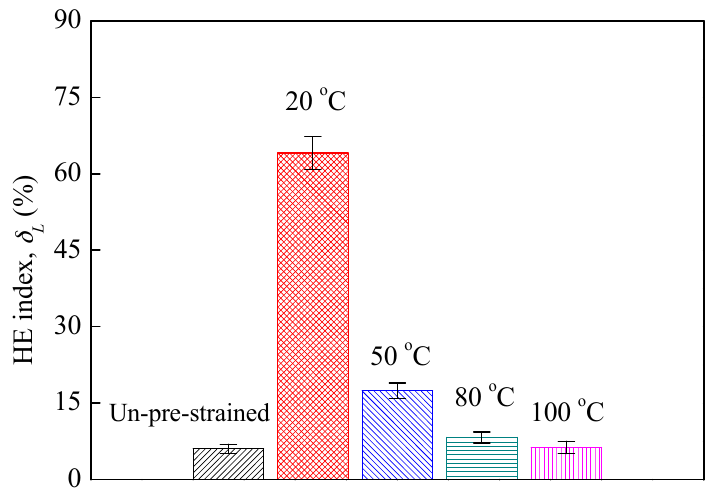
Figure 4. Hydrogen embrittlement (HE) index of hydrogen-charged specimens.